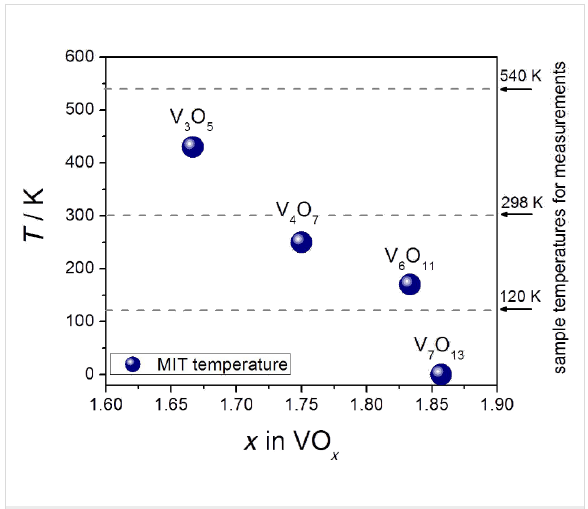
Figure 1: Metal–insulator transition (MIT) temperatures of the investi- gated Magnéli-type vanadium oxide crystals [1,26]. V 7 O 13 does not show an MIT. The right scale shows temperatures where force measurements were carried out to probe the metallic and the insu- lating state of each